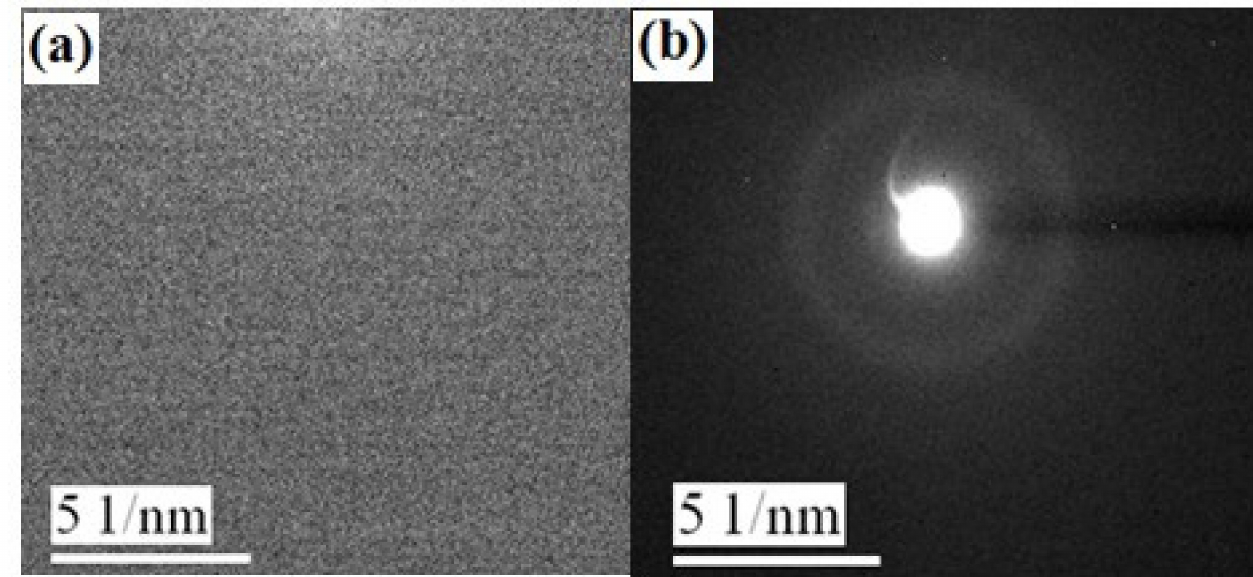
Figure 2. ( a ) HRTEM micrograph; ( b ) the electron diffraction pattern of Al 2 O 3 -(3-x)SrO: xSm 3+ glass with x =